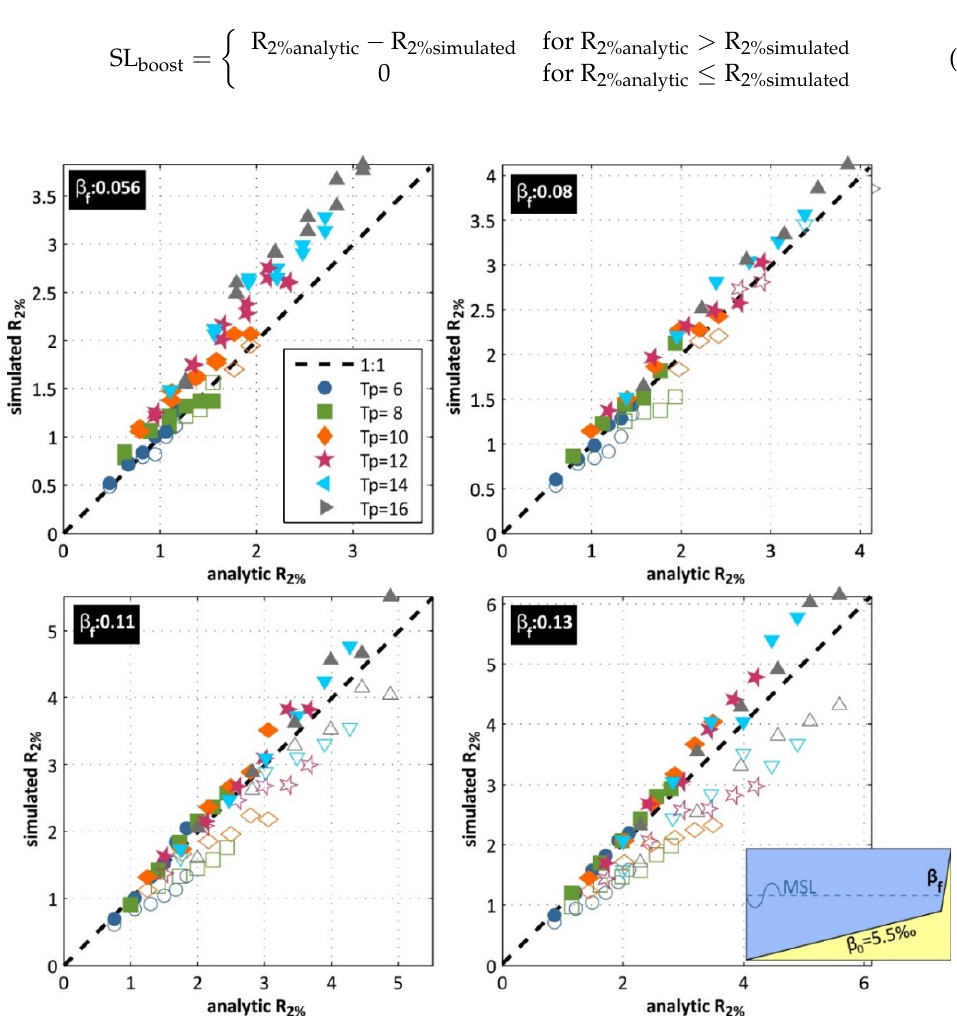
Figure 5. Comparison of analytic R 2% runup heights, calculated after [46], and simulated values be- fore (non-filled symbols) and after correction (filled symbols) for different beachface slopes ( β f = 0.056, 0.08, 0.11 & 0.13) and incident waves (T p = 6–16 s, noted on the legend, and H s =1, 2, 3, 4, 5 & 6 m). The correction (SL boost) was applied only when R 2% was underestimated by XBeach, otherwise both runs have the same simulated R 2% value (filled and non-filled symbols overlap). A sketch of the idealized profile, used, is given in the lower-right